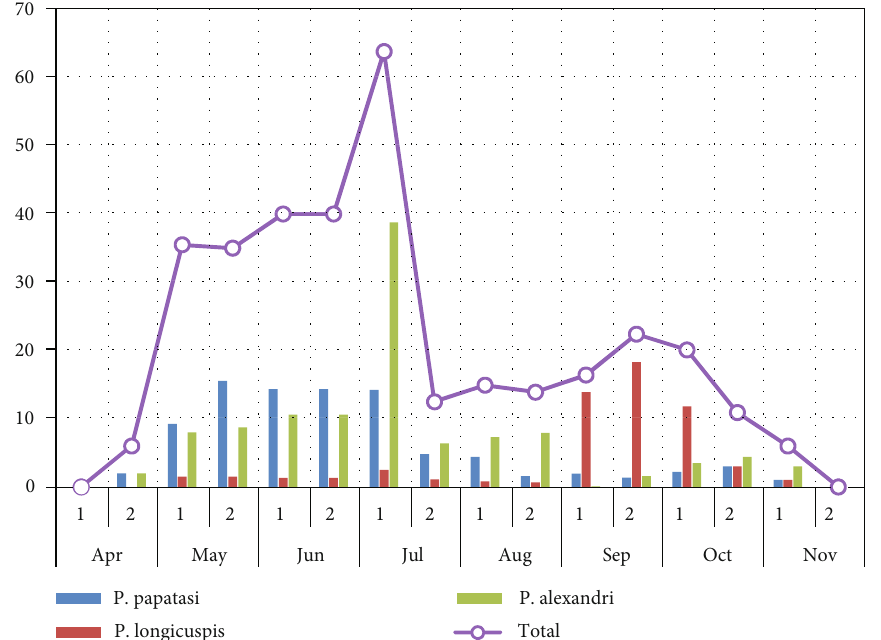
Figure 3: Bimonthly capture records for sand fl ies in Touna